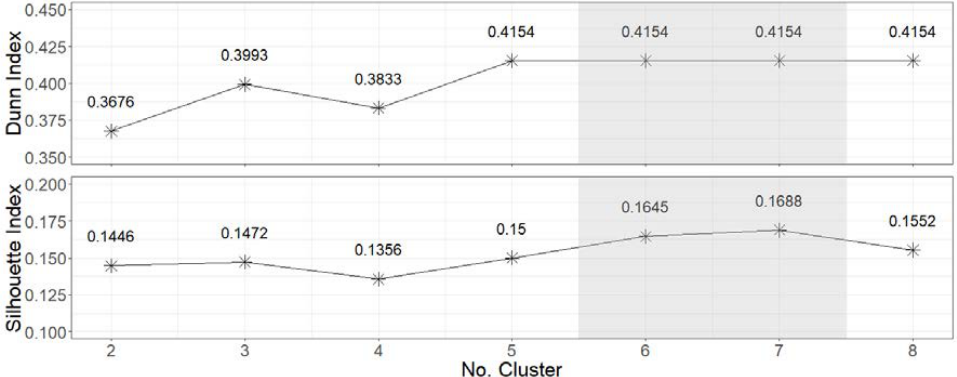
Figure 3. Cluster Evaluation (best evaluated in grey).